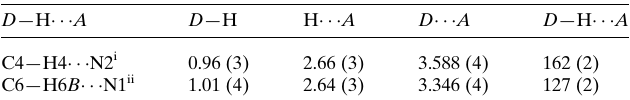
Table 1 Hydrogen-bond geometry (A˚ , (cid:2)